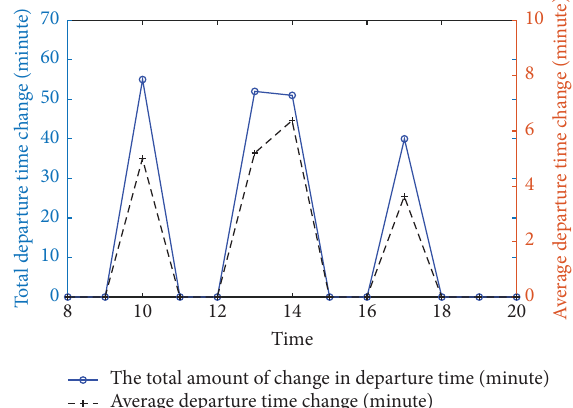
Figure 23: Te aircraft volume, the total amount of changes in departure time, and their average.